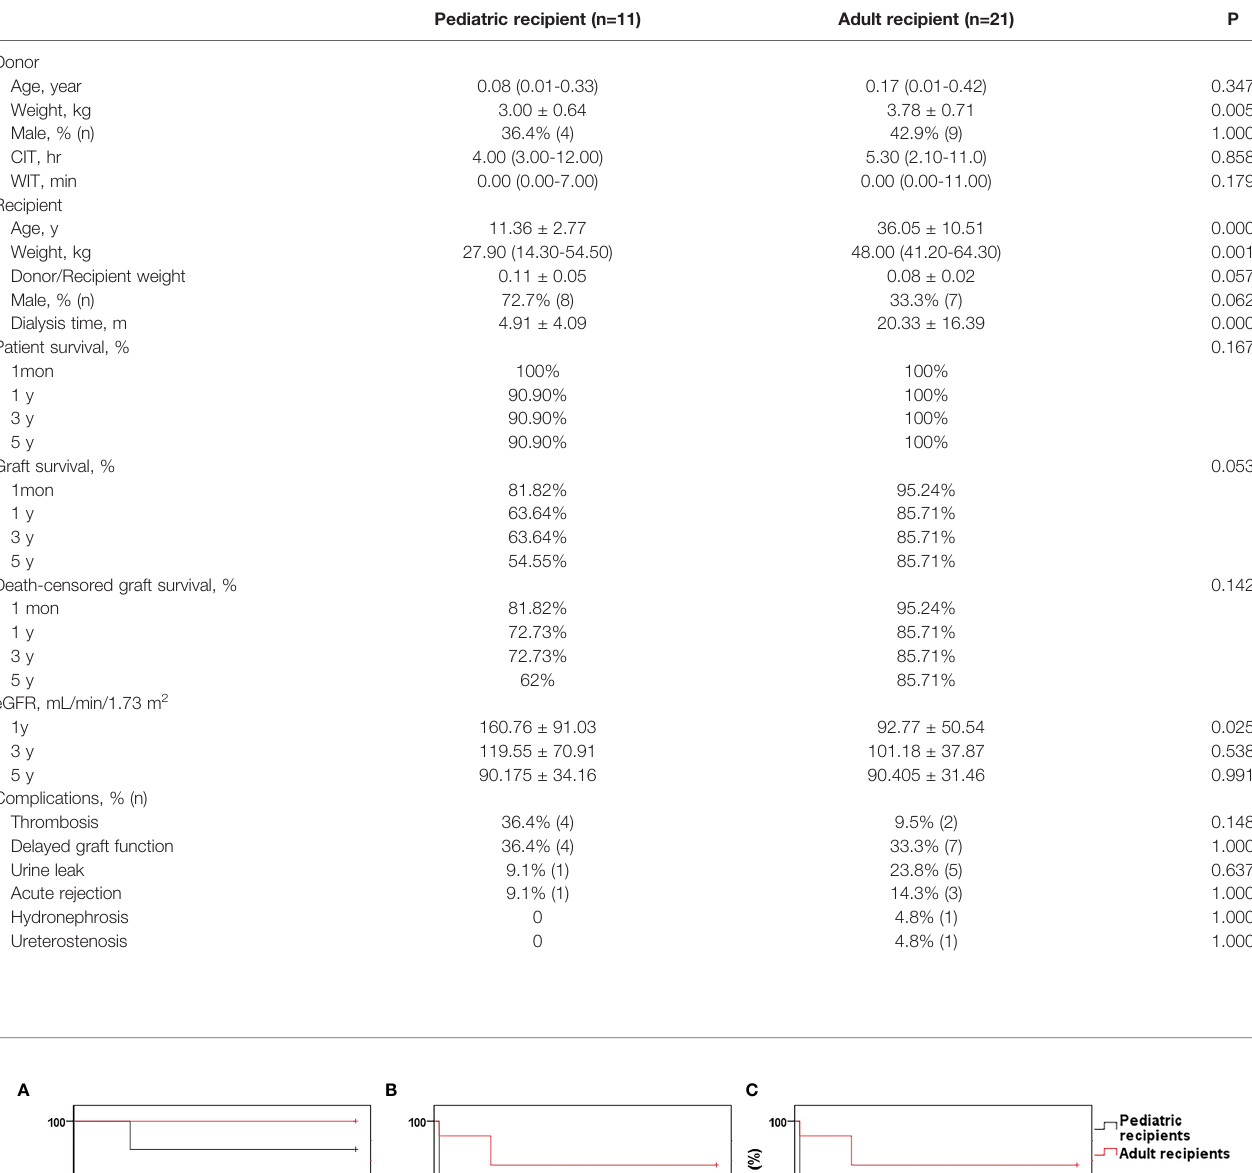
TABLE 4 | Subgroup comparison of kidney transplantation using grafts obtained from pediatric donors of extremely low body weight with different